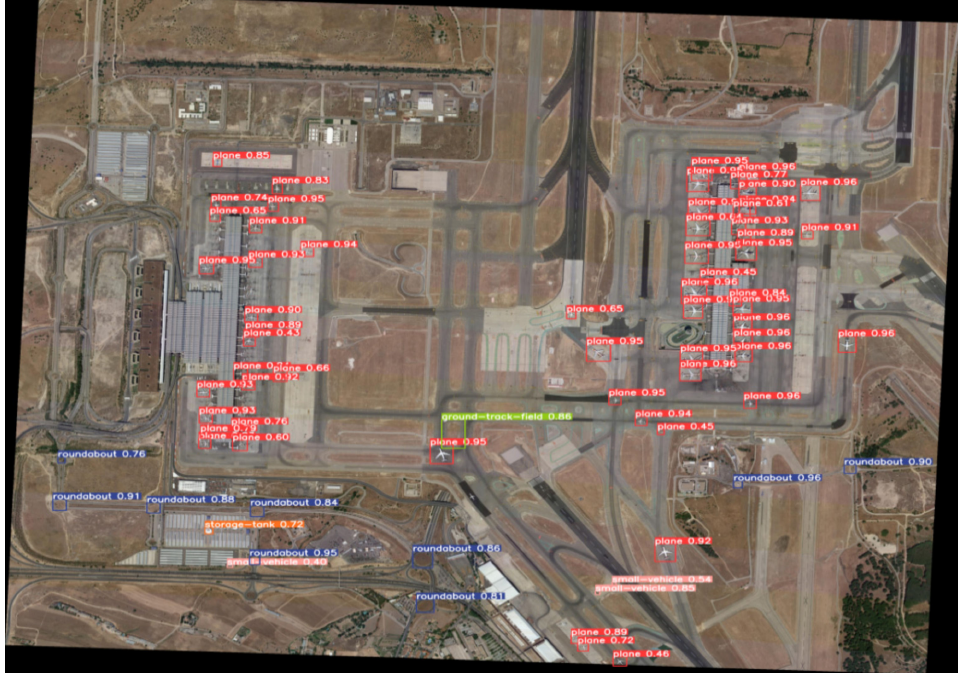
Figure 10. The detection results of the YOLOX model combined with the SAHI framework for the same high-resolution